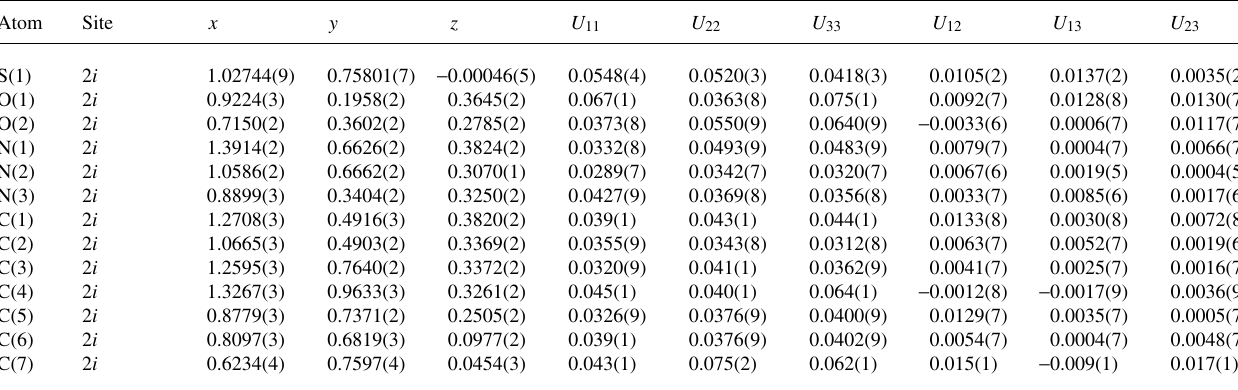
Table 3. Atomic coordinates and displacement parameters (in Å 2 )